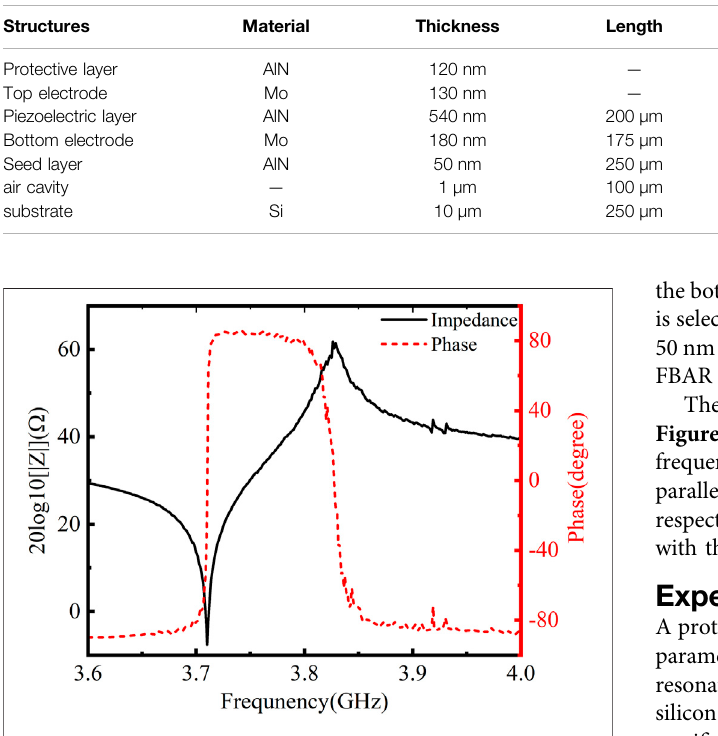
FIGURE 5 | Amplitude and phase of Z plotted for the optimized